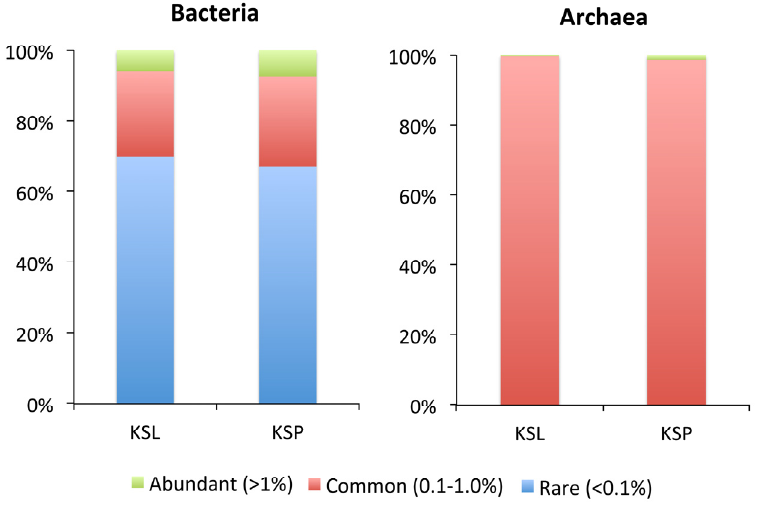
Figure 5. The percentage of abundant, common and rare bacterial and archaeal operational taxonomic units (OTUs) in two water wells (KSL and KSP) of the Lake Karla Basin,